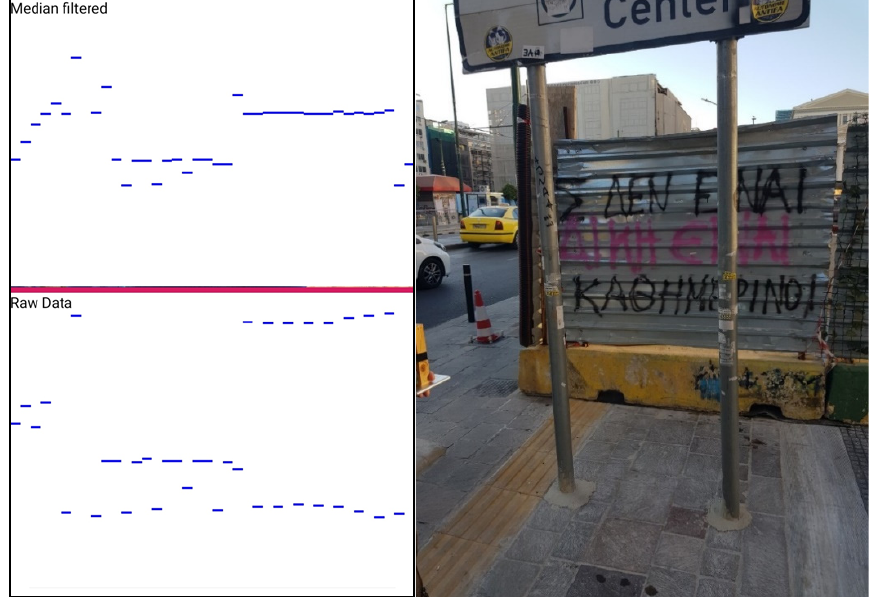
Figure 23. Response of sonar obstacle detection system.